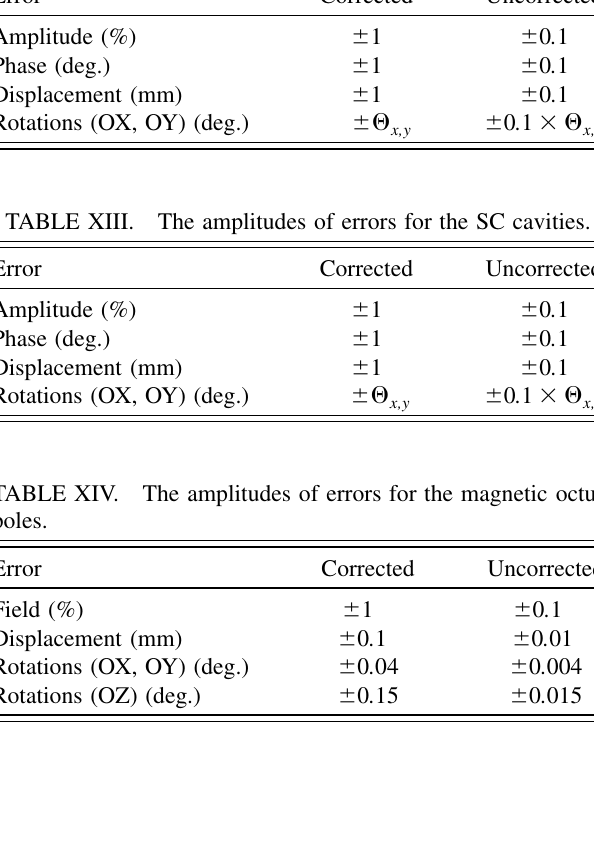
TABLE XII. The amplitudes of errors for the buncher cavities. Error